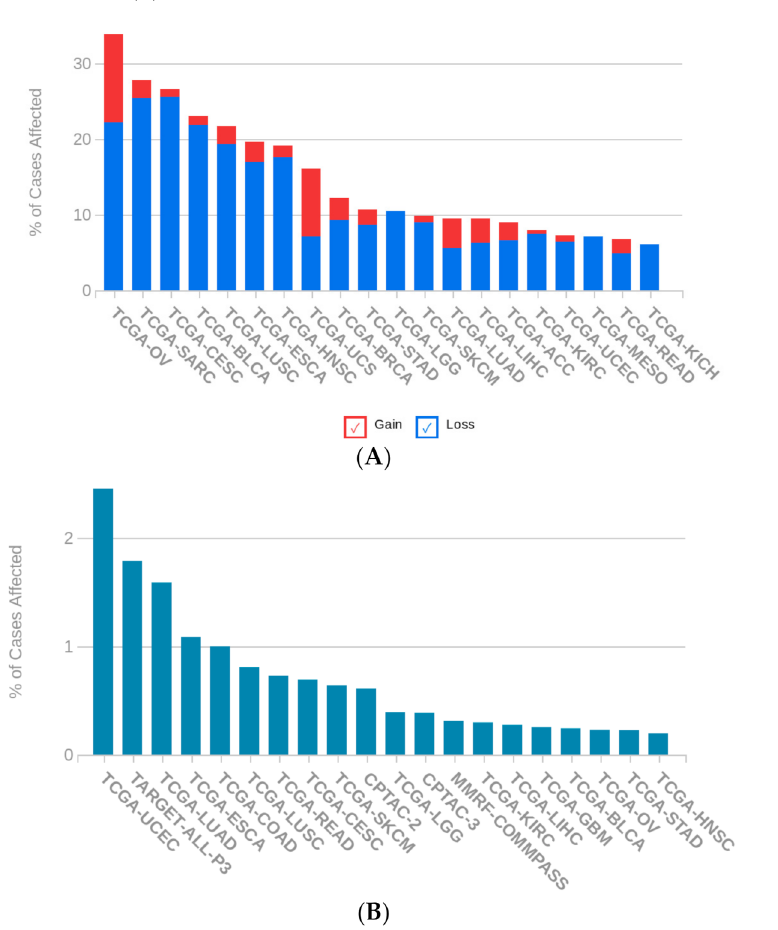
Figure A3. CNV and mutation distribution of PD1 (PDCD1) in different cancer types. ( A ) CNV distribution. ( B ) Mutation